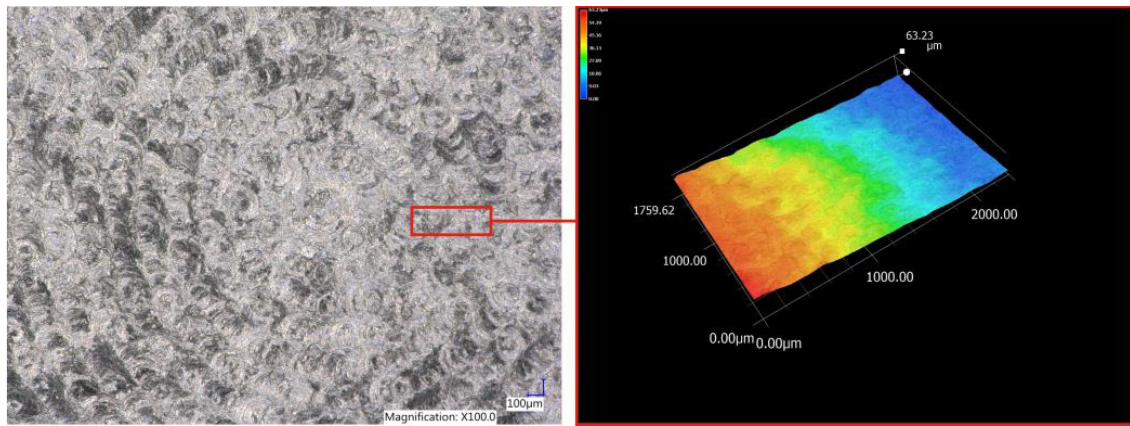
Figure 26. Display of surface texture and SH in THE constant stepover-pocket auto border strategy.